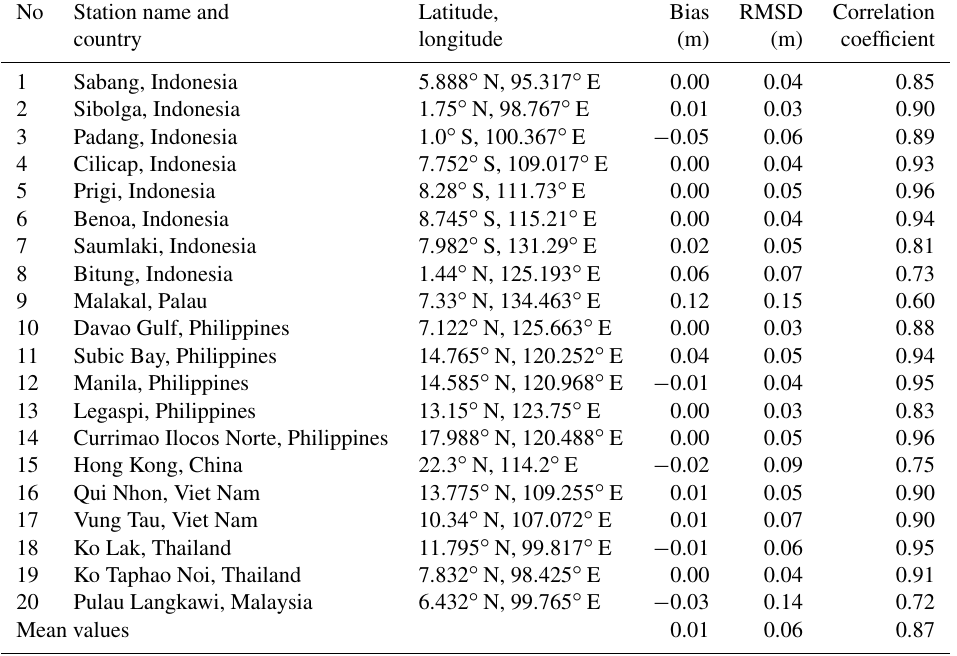
Table 3. Summary of SSH bias, RMSD, and correlation coefficient statistics between MCO hindcast and tide gauge stations for the period 1 January 2018 to 30 June 2019. Daily mean SSH from model and tide gauge is used for the analysis.